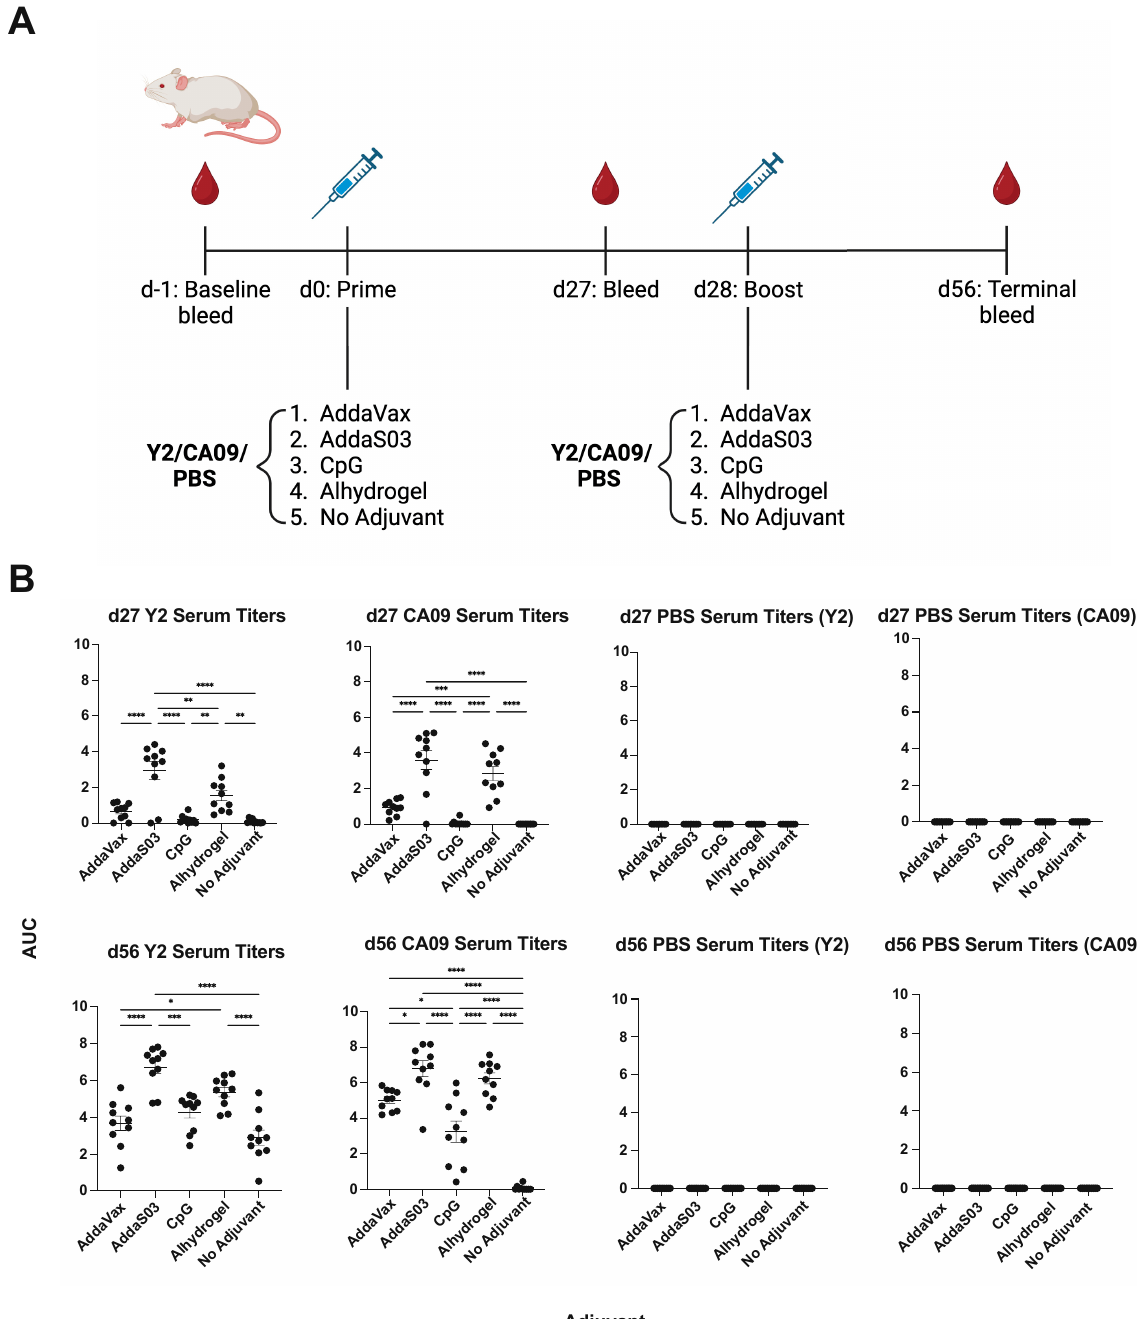
Figure 1. H1 HA immunization schedule and serum IgG titers after adjuvanted vaccination with Y2 and CA09 HAs. ( A ) Overall immunization scheme of the H1 HA study. Time points for bleeds and vaccinations are shown. ( B ) Titers of IgG antibodies in sera from vaccinated mice, determined by ELISA, are shown for 27 days post-prime after one immunization (d27, top) for all groups against the homologous immunizing HA. Titers for both HAs are shown for the PBS immunization control. Those at 56 days post-prime (28 days post-boost) are shown on the bottom. Titers are represented as area under the curve (AUC) values, where a minimum baseline absorbance at 405 nm of 0.3 was considered a positive binding signal. *, p ≤ 0.05; **, p ≤ 0.01; ***, p ≤ 0.001; ****, p ≤ 0.0001. One-way ANOVA was used for statistical comparisons between